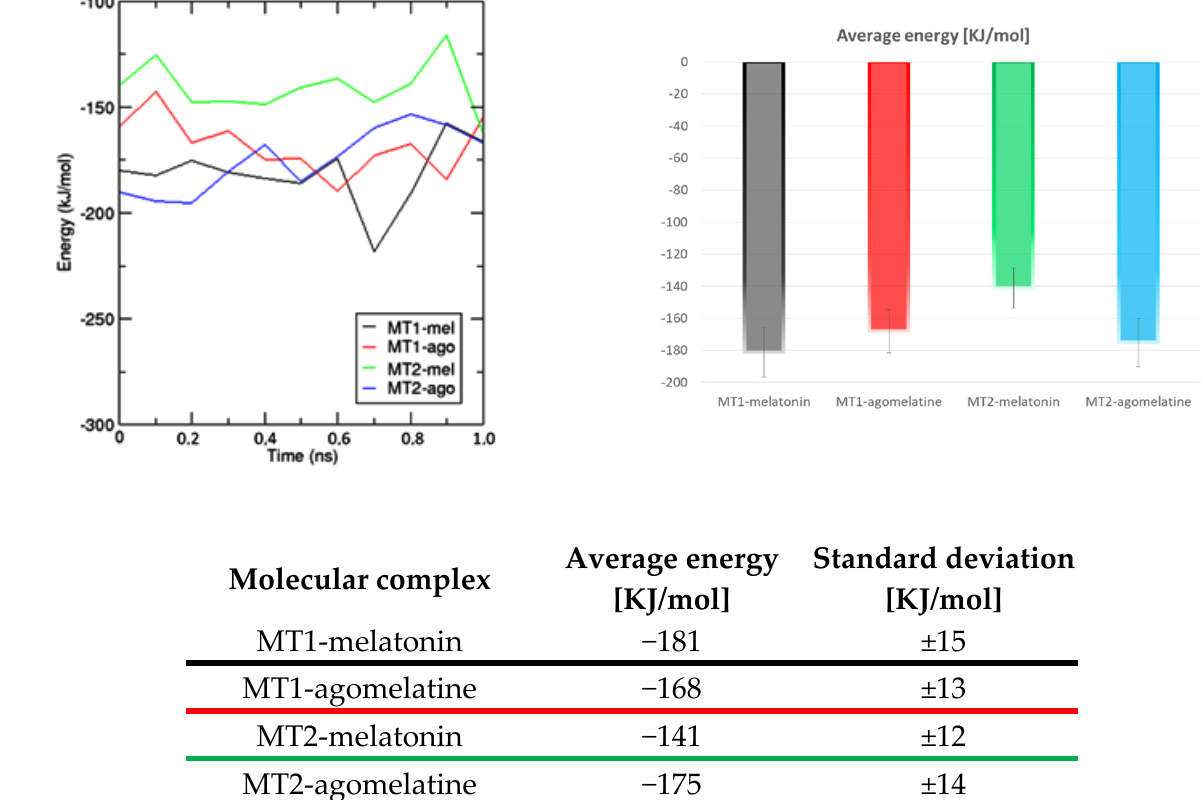
Figure 10. Melatonin and agomelatine affinity values towards h MTs in terms of free binding energy calculated using MMPBSA in 1 ns and molecular dynamics simulations.